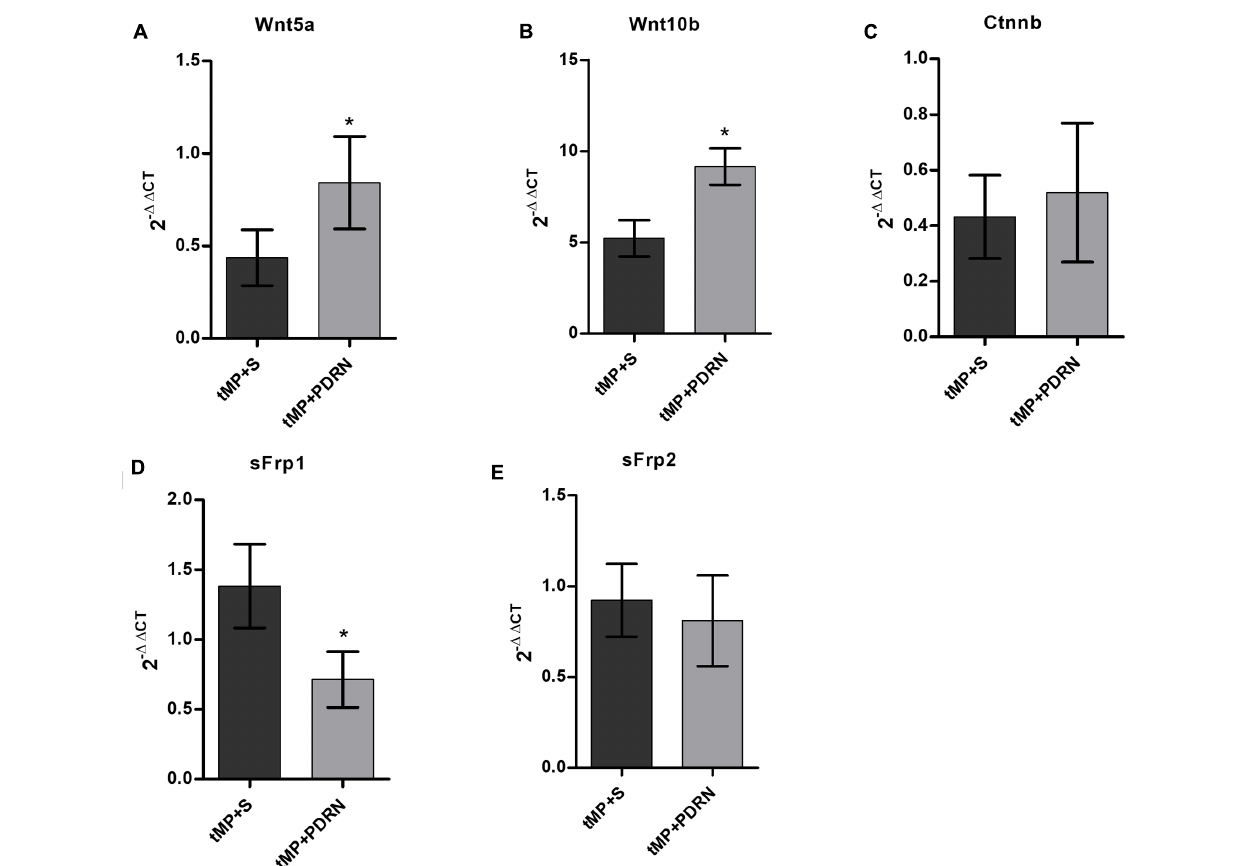
FIGURE 6 | quantitative polymerase chain (qPCR) reaction on primary osteoblasts. qPCR results obtained from primary osteoblasts. (A) Wnt5a. (B) Wnt10b. (C) Ctnnb. (D) sFrp1. (E) sFrp2. ∗ p < 0.05. Data are expressed as means and